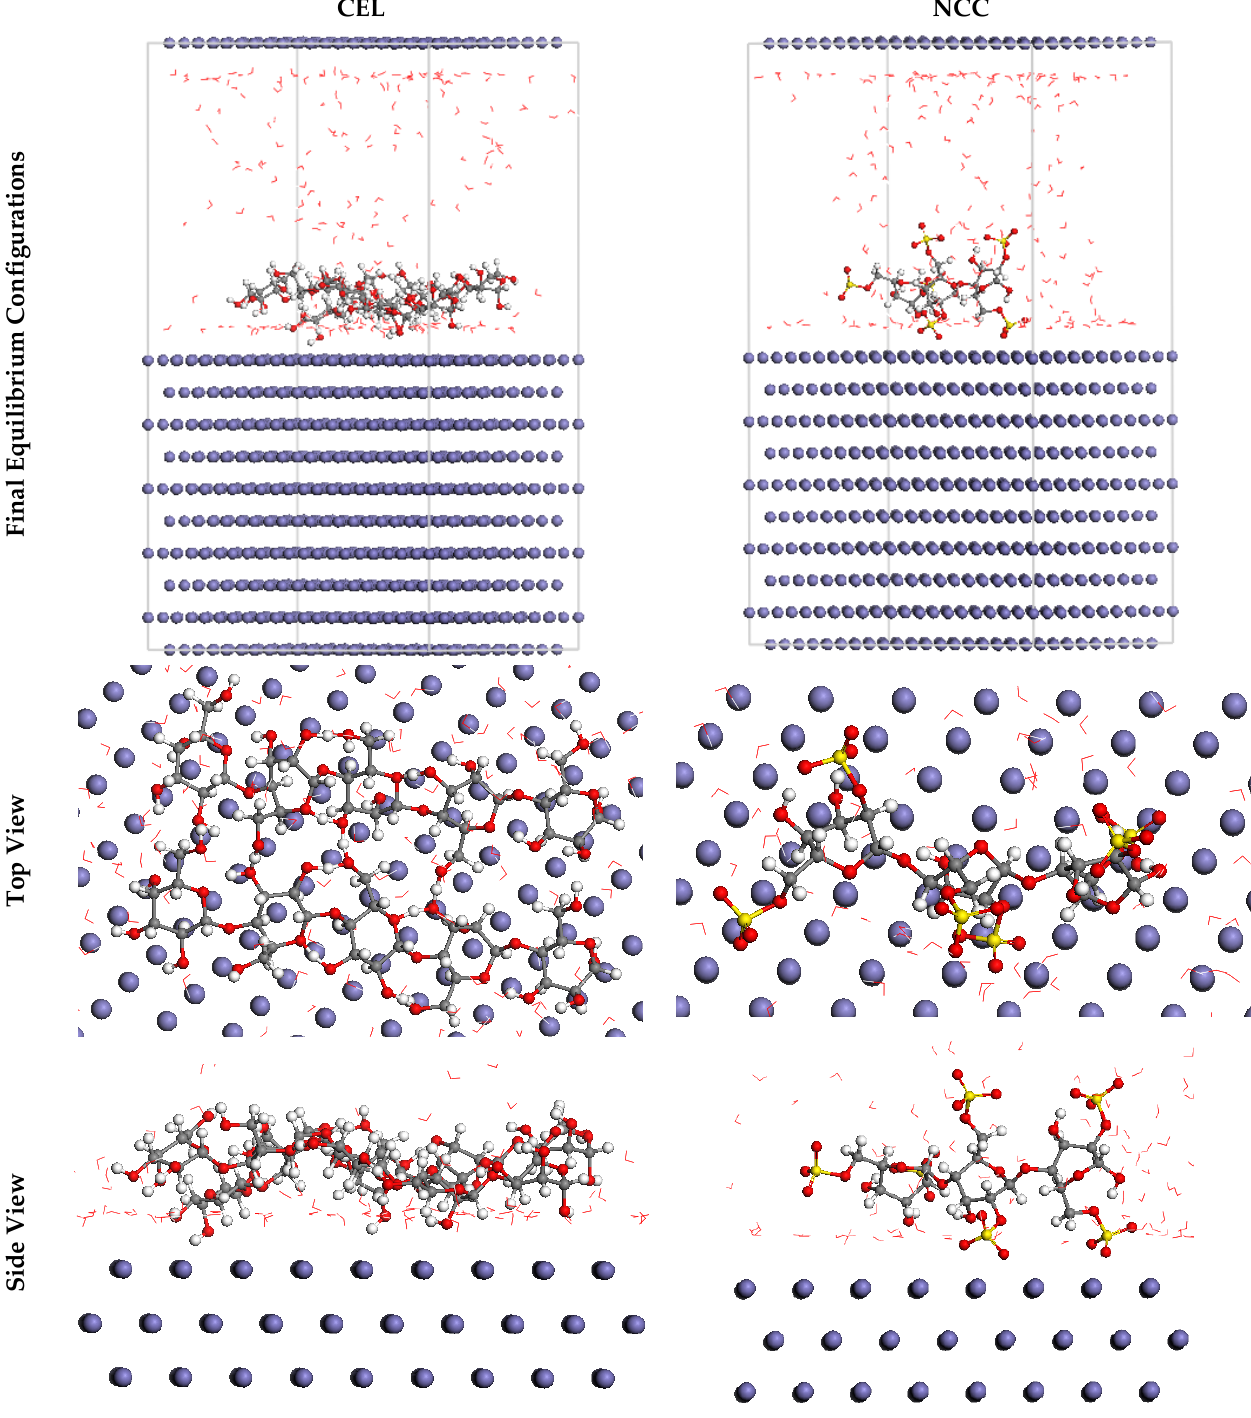
Figure 15. The most suitable configuration for adsorption of the CEL and NCC on Fe (1 1 0) substrate obtained by adsorption locator module.